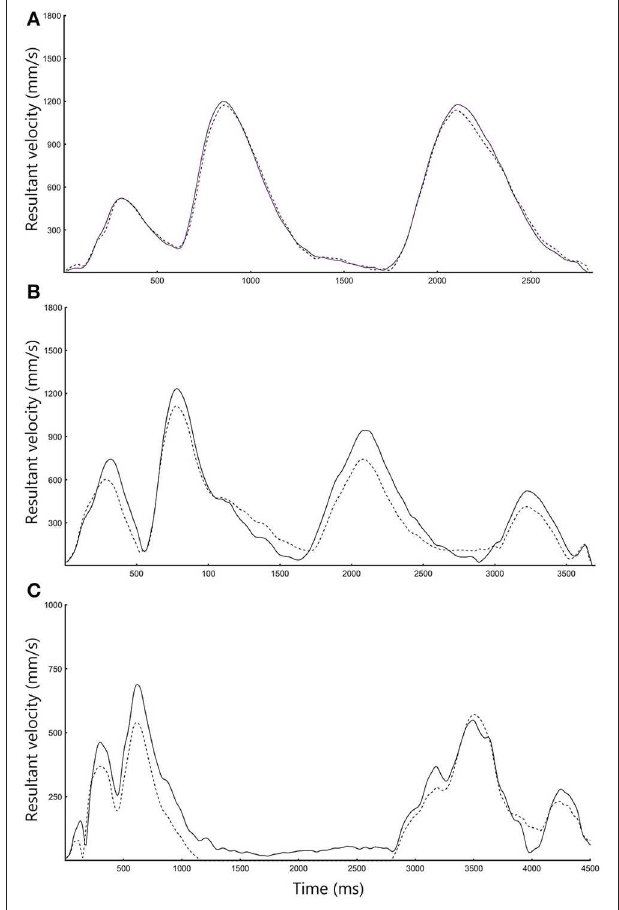
FIGURE 3 | Representative velocity trajectories for the (A) ARAT Block, (B) Drink, and (C) Pour Water task. Black lines refer to Vicon data, whereas dotted lines refer to outREACH IMU